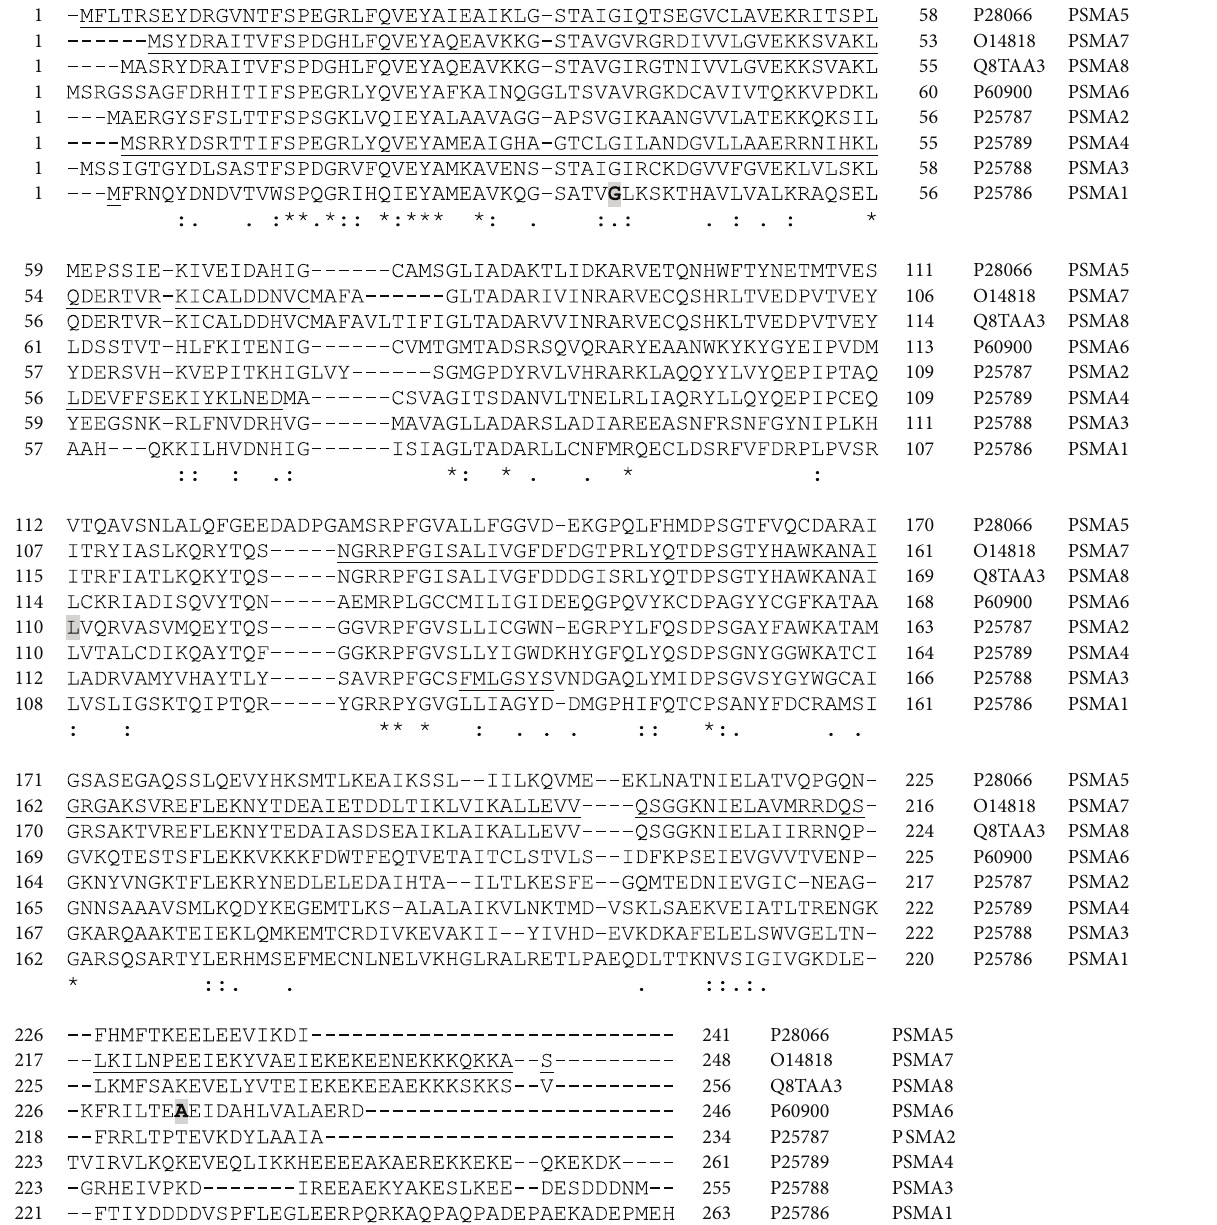
Figure 4: Alignment of human PSMA subunits 1–8. Protein sequences of the eight proteasome PSMA subunits were aligned using Clustal W. ⋆ , identical residue in all seven subunits; :, conserved amino acids with strongly similar properties;., conservation between residues of weakly similar properties. Naturally occurring variants are highlighted with grey boxes. Alternatively spliced regions are underlined. Amino acid residue numbers are shown on the left and right of each sequence and the UniProt accession number and gene name of each sequence are shown to the right of each sequence. PSMA8 (PSMA7L) is found only in mammalian testis and is a spermatid/sperm-specific 𝛼 subunit